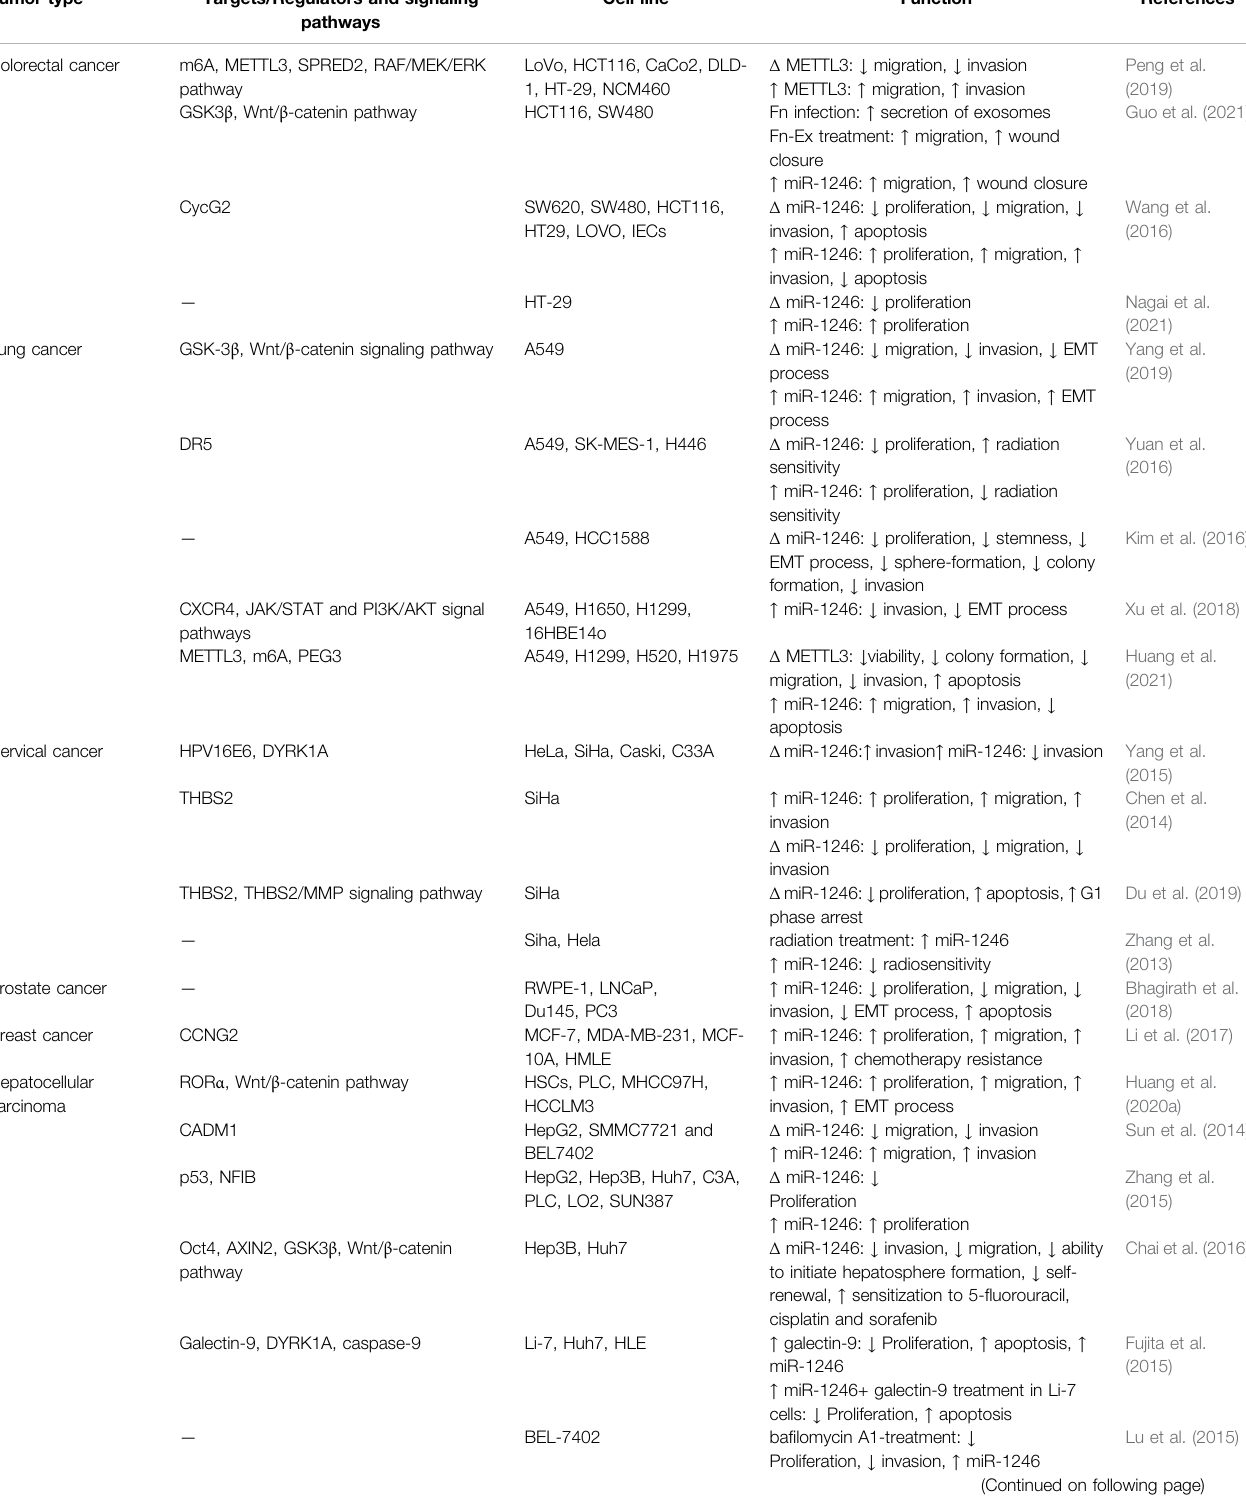
TABLE 1 | Outlines of in vitro studies about function of miR-1246 ( Δ : knock-down or deletion, FN: Fusobacterium nucleatum, sEV: Small extracellular vesicle, GEM: gemcitabine). Tumor